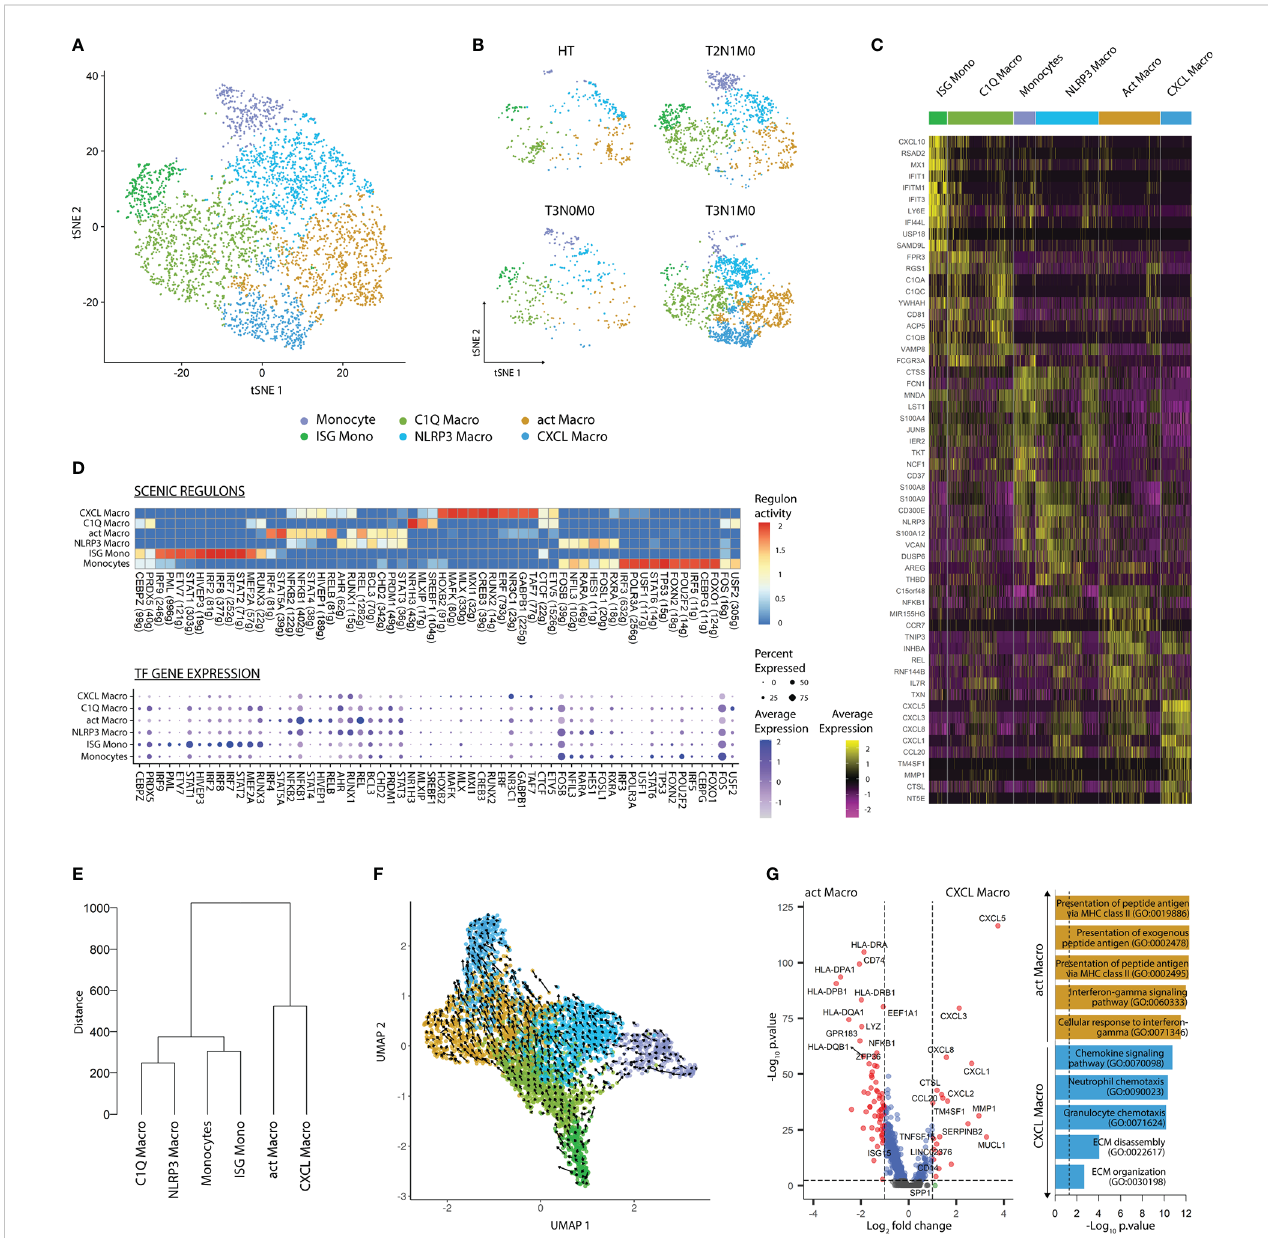
FIGURE 3 Mono-Mac subsets display tumor-stage speci fi c patterns. (A) tSNE plot showing the six transcriptomically unique Mono-Mac clusters across cancer and healthy tissues. (B) tSNE plot of Mono-Mac distribution according to TNM classi fi cation. (C) Heatmap of the top 10 DEG per cluster after DGEA (FC > 1.5, p-value < 0.05). (D) Heatmap of the top 10 regulons per cluster colored by regulon activity (upper) and dot plot displaying the gene expression levels of each regulon ’ s TF per cluster (lower). (E) Dendogram of Mono-Mac clusters based on Euclidean distance. (F) UMAP plot showing the